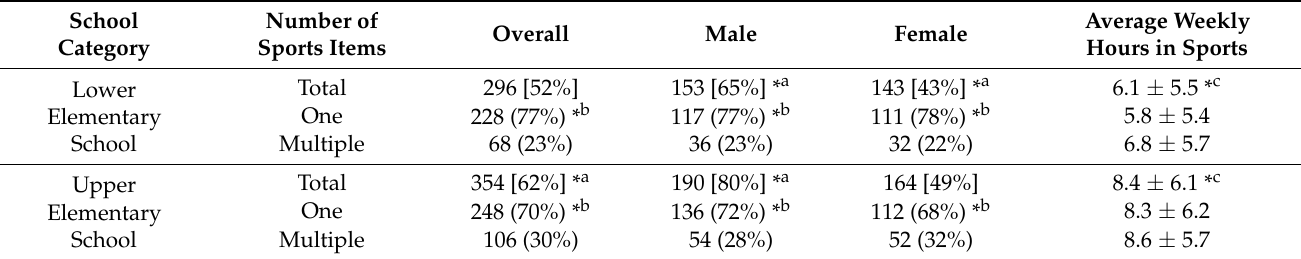
Table 2. Characteristics of sports items and weekly hours in